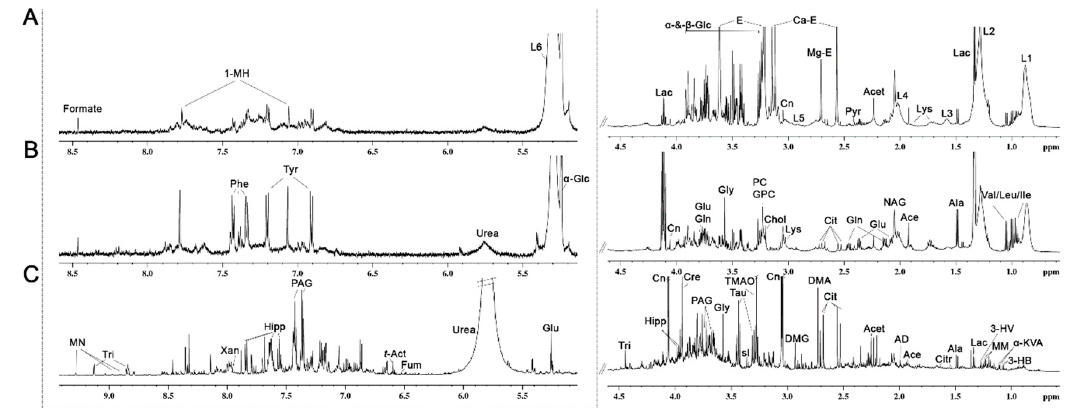
Figure 1. Representative 600-MHz high-resolution proton nuclear magnetic resonance ( 1 H NMR) spectra of plasma ( A ), interstitial fluid ( B ) and urine ( C ). The regions of δ 5.0–8.5 for plasma and interstitial fluid and δ 5.0–9.4 for urine were magnified compared with the corresponding regions δ 0.6–4.5 for purposes of clarity. Abbreviations: L1: lipid-CH 3 ; L2: lipid –(CH 2 )n; Lac: lactate; L3: lipid